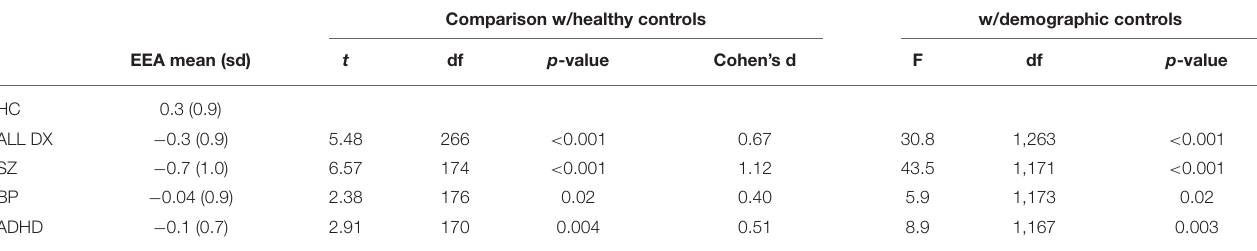
TABLE 2 | Reduced efficiency of evidence accumulation (EEA) in healthy controls vs. patients with psychiatric disorders. Comparison w/healthy controls w/demographic